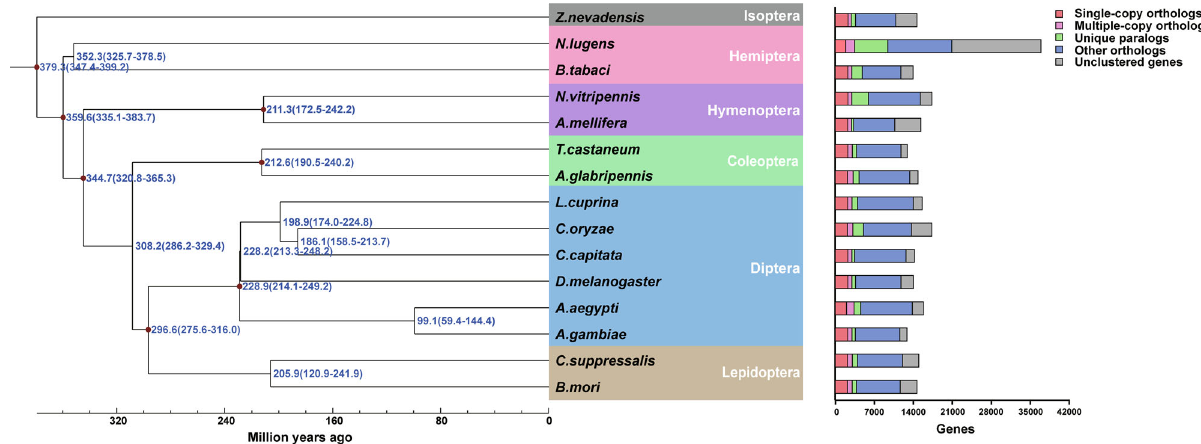
Fig. 3 Phylogenetic tree and gene orthology of Chlorops oryzae and 14 other insect genomes. Phylogeny inferred from identi fi ed single-copy genes in PhyML using the maximum likelihood method (100 bootstrap replicates). Divergences were estimated by the BRMC method using